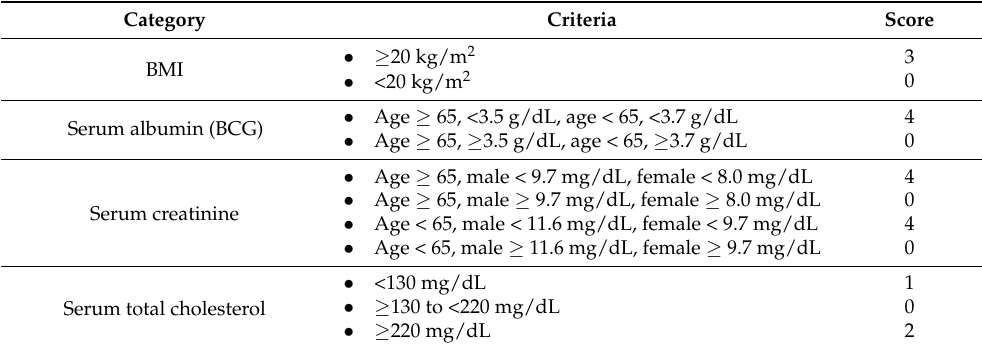
Table 4. NRI-JH evaluation